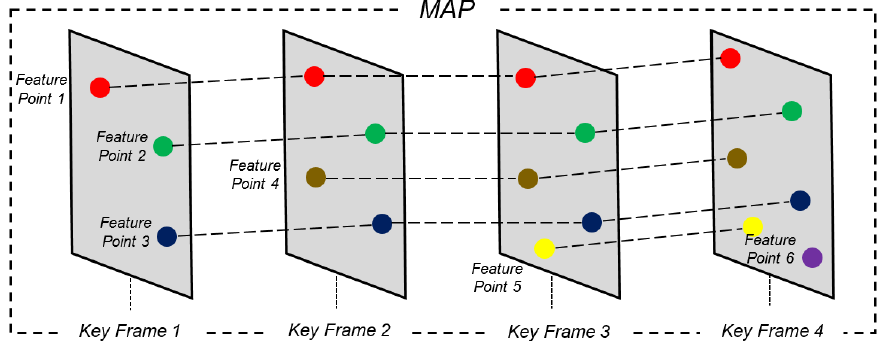
Figure 10. Features extraction process based on